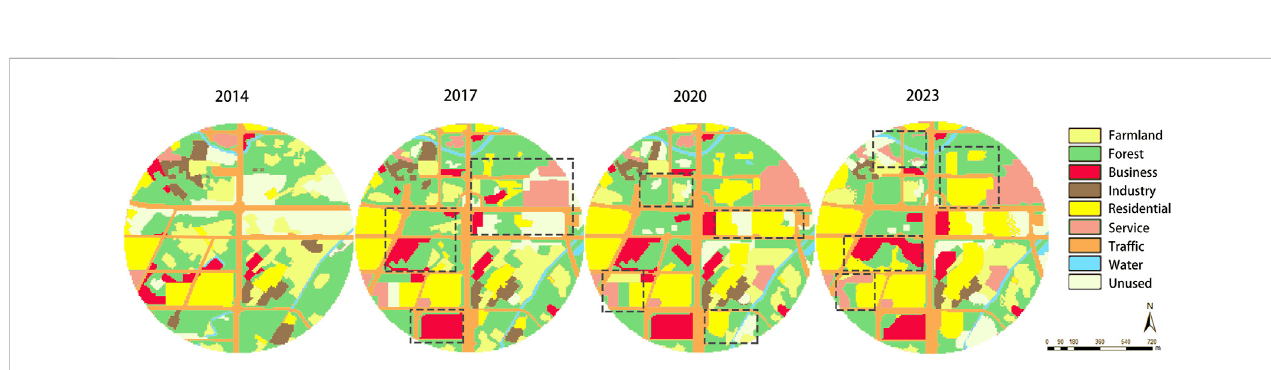
FIGURE 7 Land use maps of 2014, 2017, 2020 and predicted land use maps of 2023 at Lu Xiao Station.